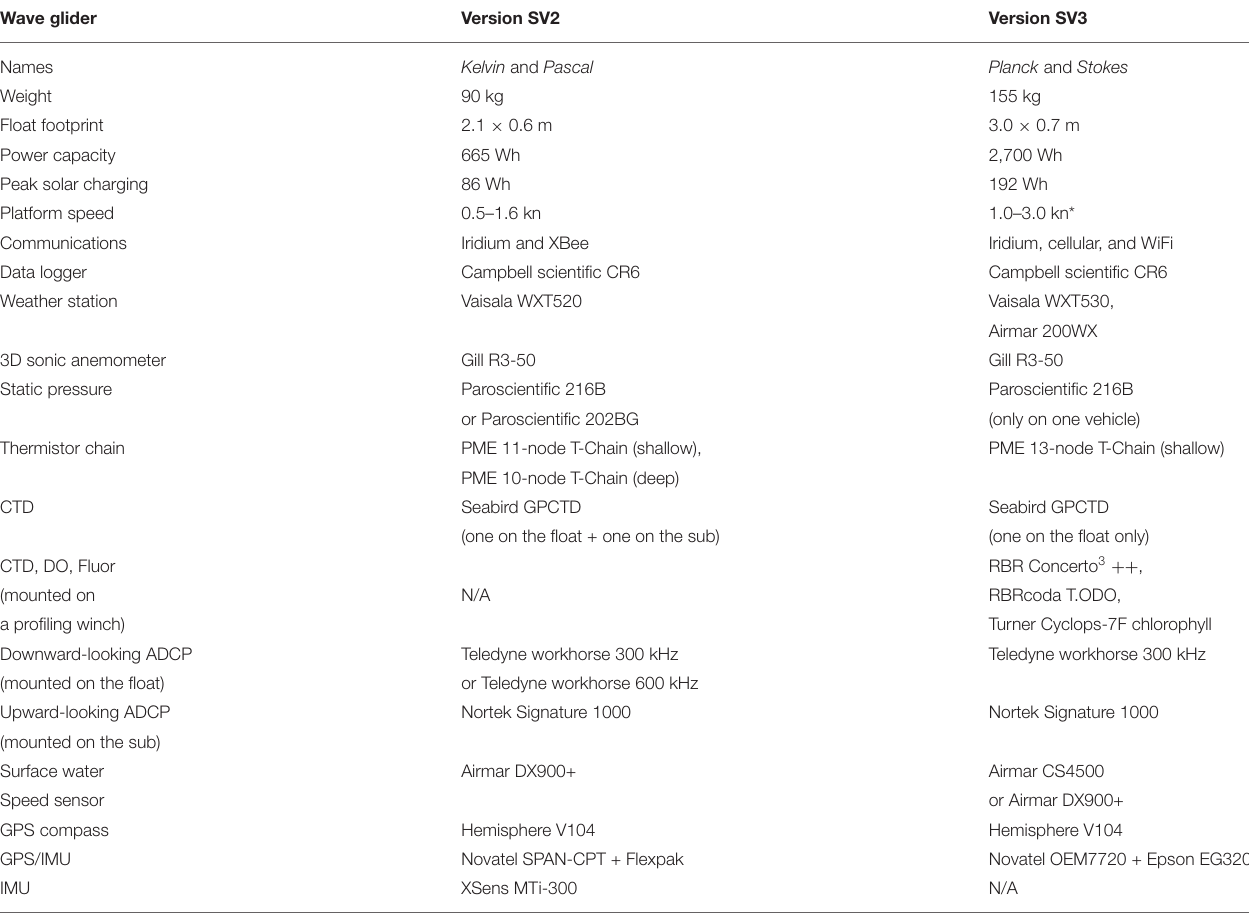
TABLE 1 | General specifications for the Liquid Robotics SV2 and SV3 Wave Glider versions and their respective air-sea interaction payload